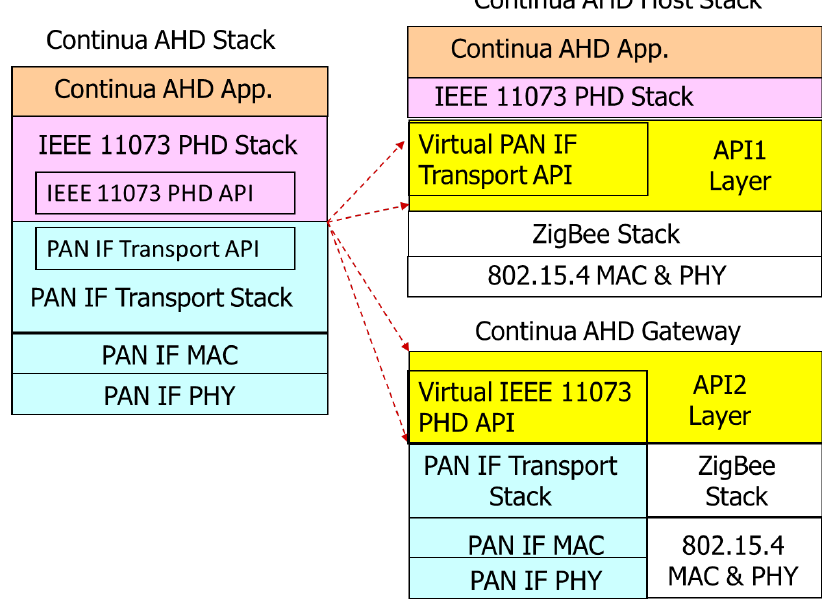
Figure 2. Communication layered stacks and interfaces in Continua AHD, Continua AHD Host, and Continua AHD Gateway.